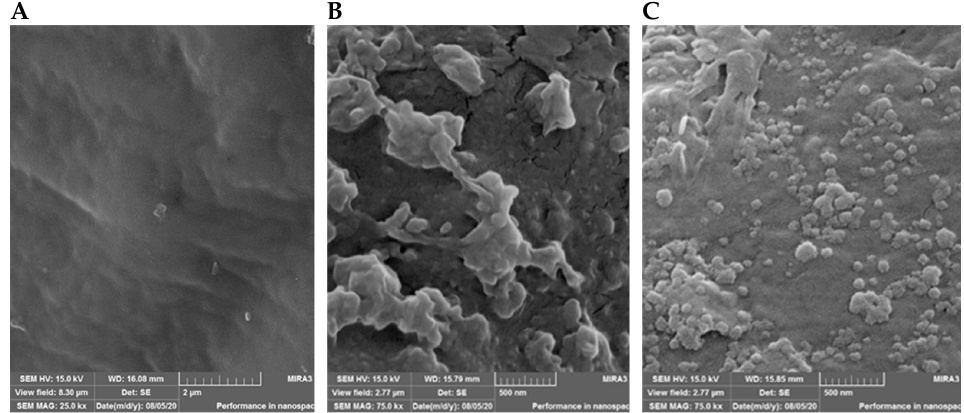
Figure 3. Representative field-emission scanning electron microscope image of untreated leaf ( A ), as well as leaf treated with either chitosan ( B ) or TiO 2 ( C ) nanoparticles.